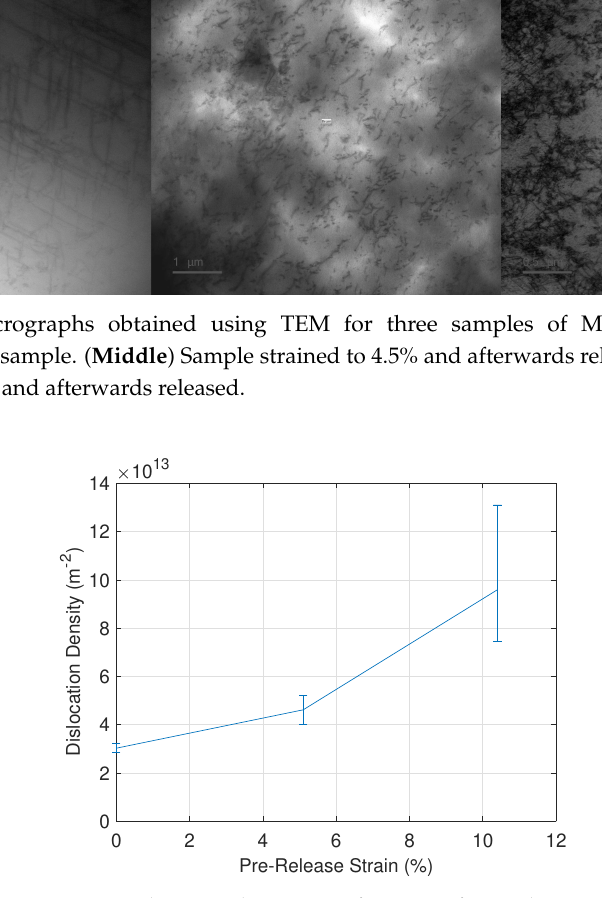
Figure 13. Dislocation density as a function of pre-release